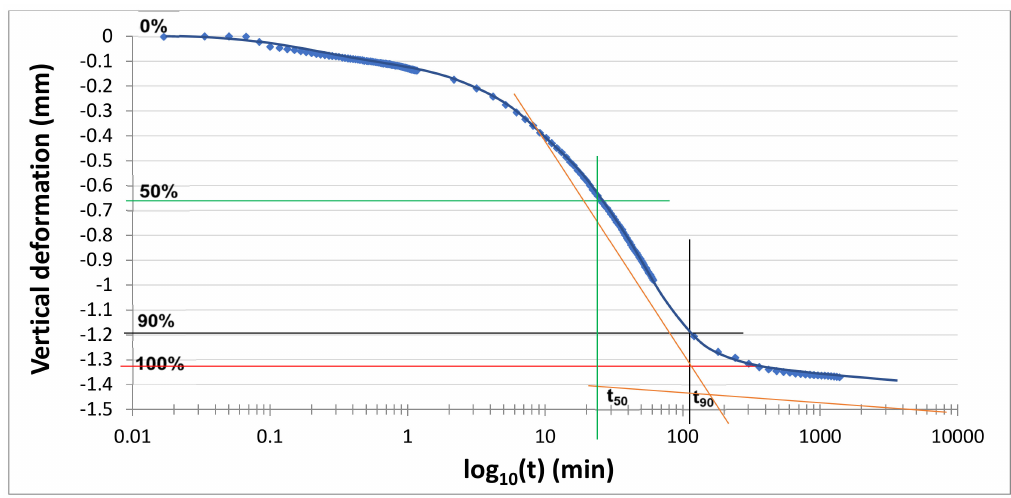
Figure 5. Consolidation curve of loading step 2 (high content muscovite soil).